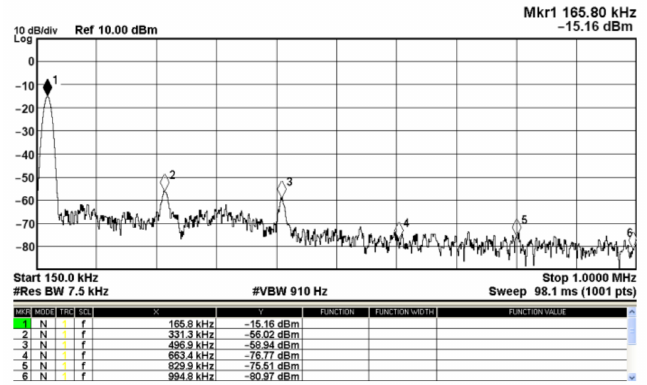
Figure 36. The frequency spectrum results of the NBPF at the output of V BP5 .